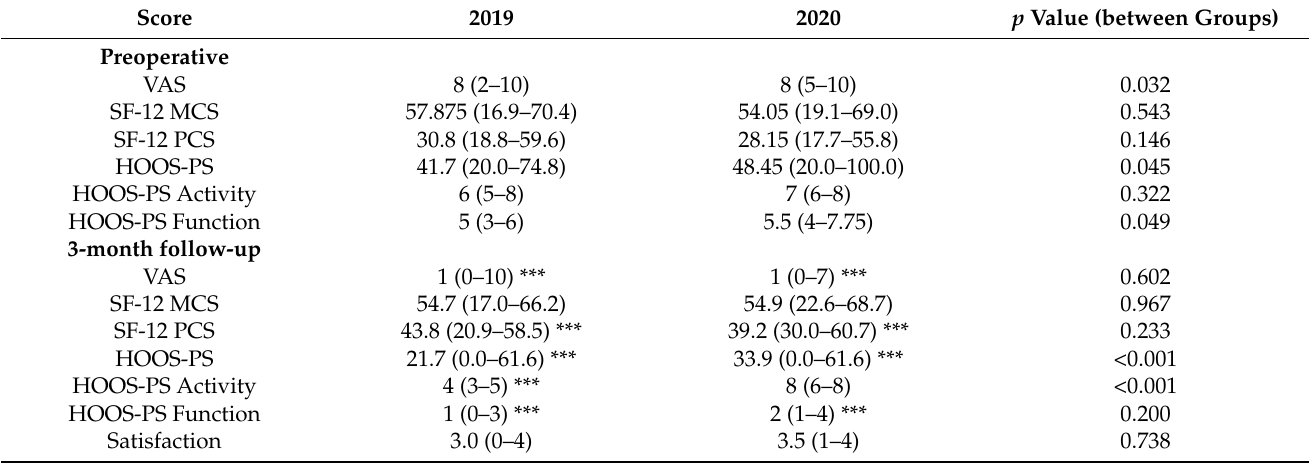
Table 2. PROMs in THA